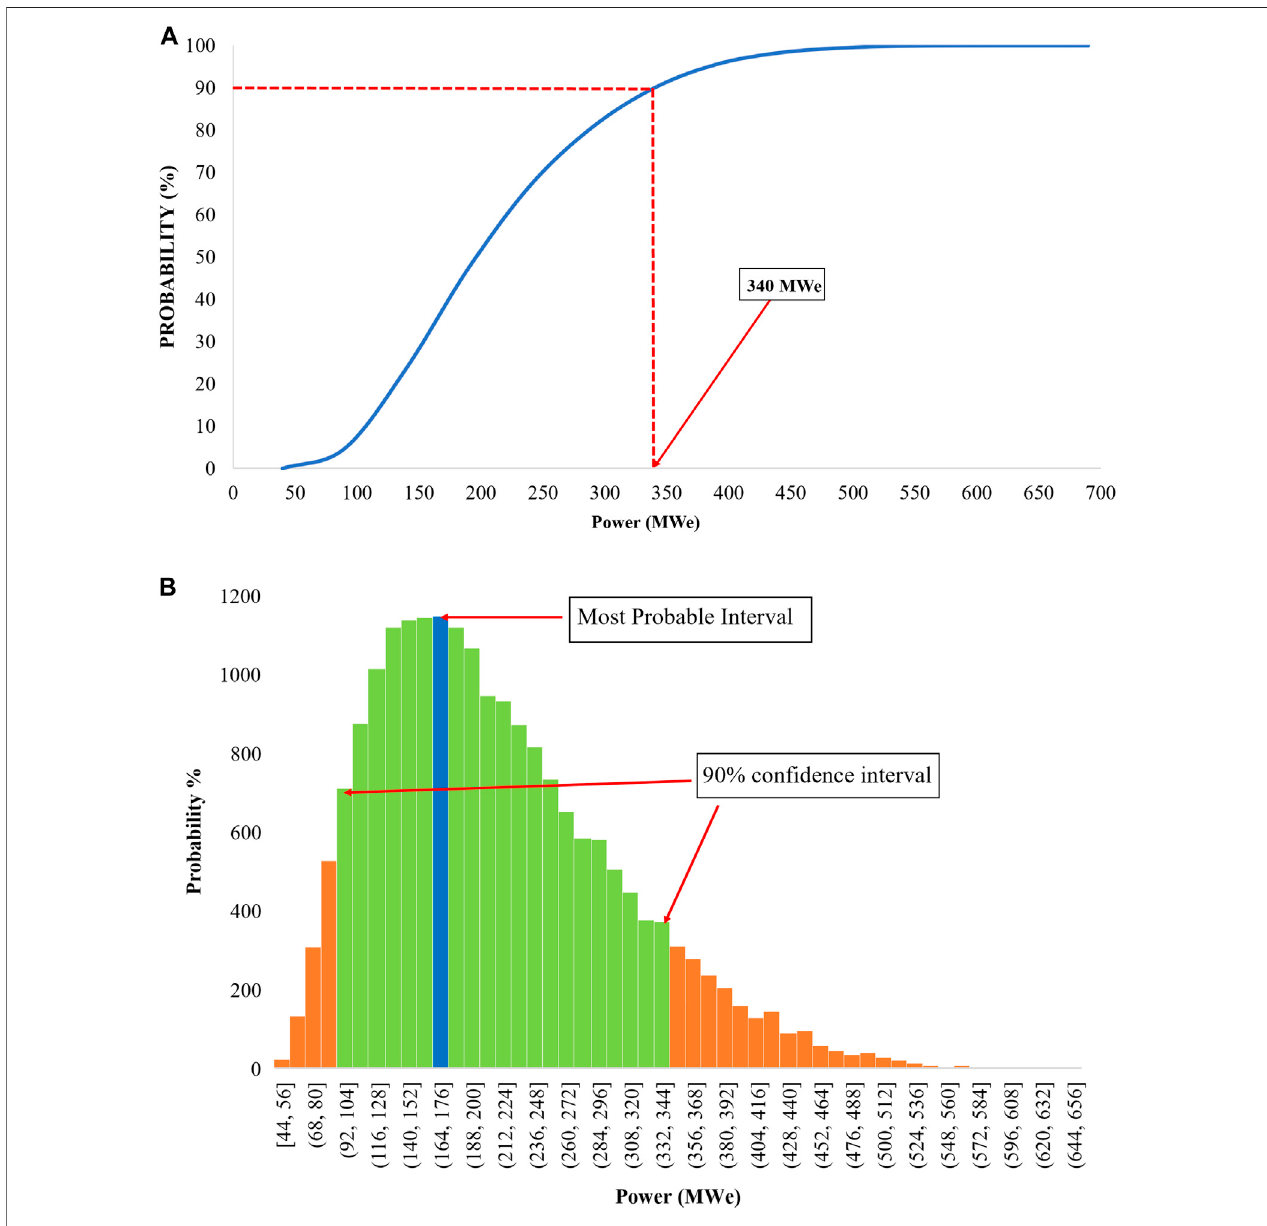
FIGURE 10 | Monte Carlo probability distribution analyses for electrical power production (MWe) for SVG03, (A) volumetric cumulative and (B) frequency.